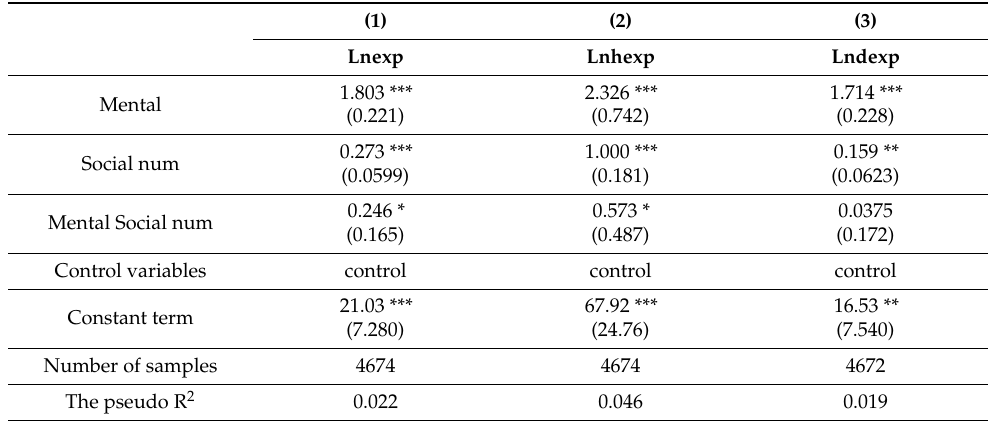
Table 9. The effect of social activity participation on health